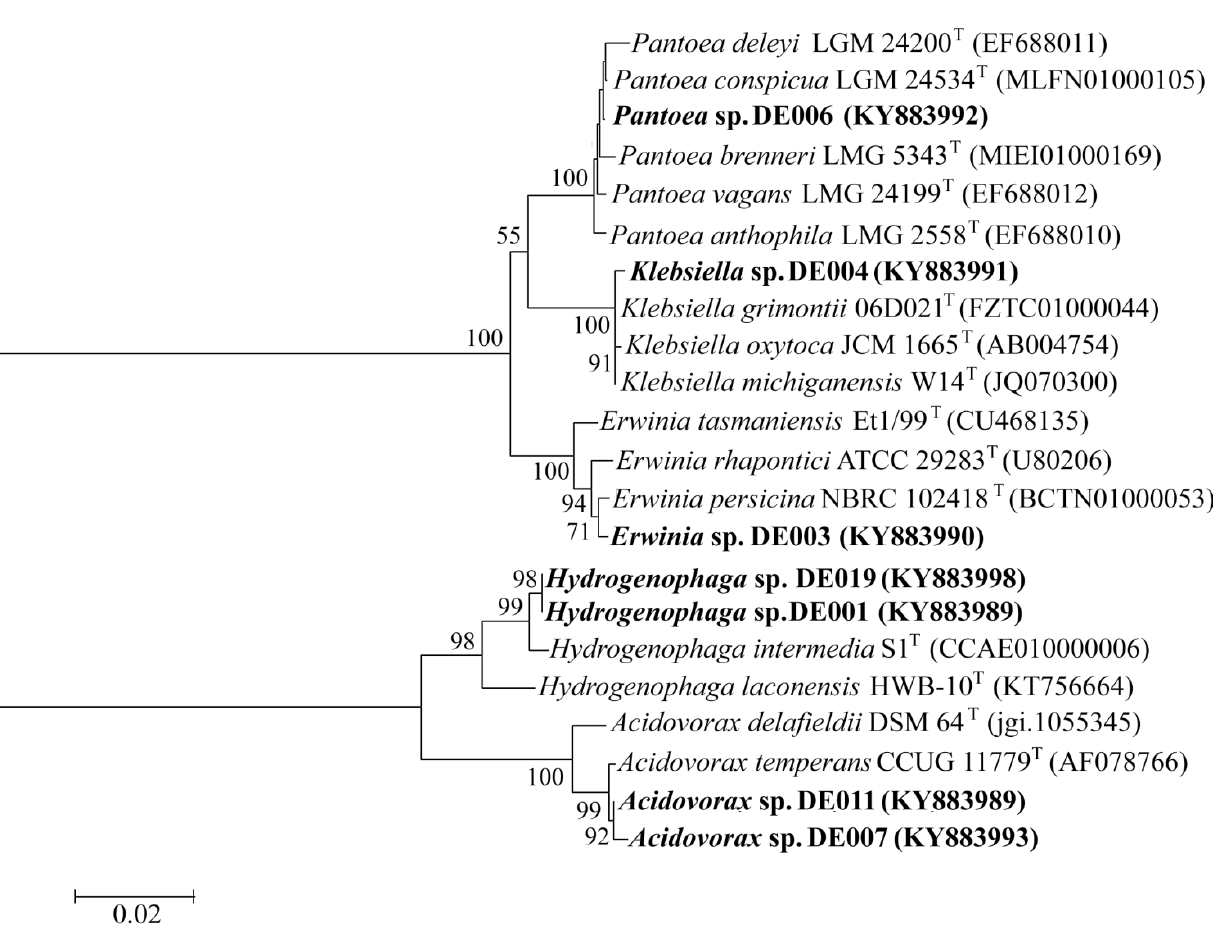
Fig 4. Neighbor-joining tree reconstructed based on 16S rDNA gene sequences showing the phylogenetic relationship between Gram-negative isolates and closely related type strains. Bootstrap values (500 replication) >50% are given at